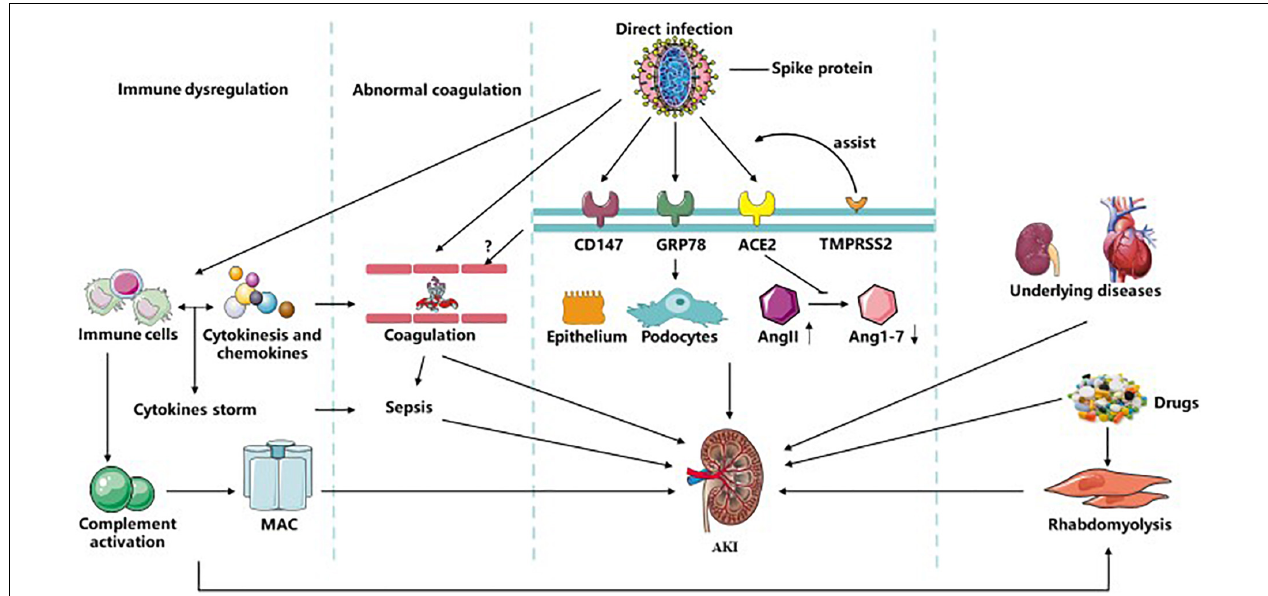
FIGURE 1 | Related mechanisms of AKI in COVID-19. SARS-CoV-2 could infect kidney tissues by ACE2, CD147, and GRP78 with the assistance of TMPRESS2 and furin-like cleavage on spike protein directly to induce kidney injury. It can also affect immune system and complement system, during which MAC, various immune cells, cytokine storm and sepsis were formed and activated resulting in AKI. Abnormal coagulation could be induced by immune system or possible direct injury to vascular caused by virus and ended up with AKI. And rhabdomyolysis induced by infection or drugs participate in the occurrence of AKI. Besides, multiple drugs applied in COVID-19 and underlying diseases of patients like CKD are also causes of COVID-19 with AKI. AKI, acute kidney disease; MAC, membrane attack complex; TMPRSS2, transmembrane protease serine 2; ACE2, angiotensin converting enzyme II; CKD, chronic kidney disease.